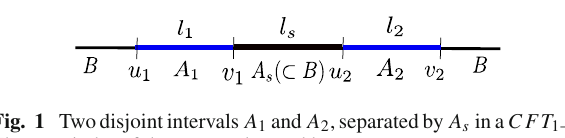
(geodesics) anchored on the corresponding spatial